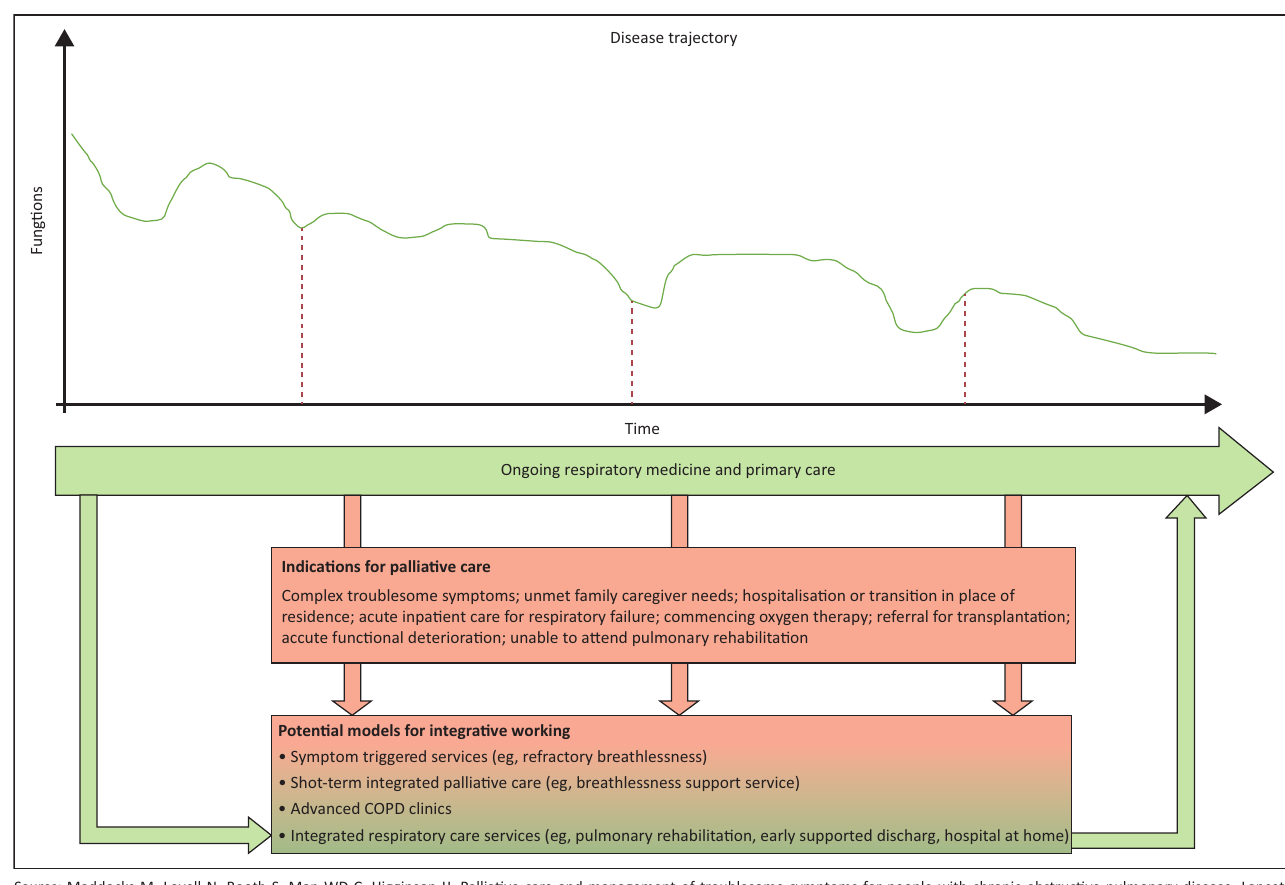
FIGURE 5: Integrated palliative care for people with progressive co-morbid disease, for example, chronic obstructive pulmonary disease (COPD).